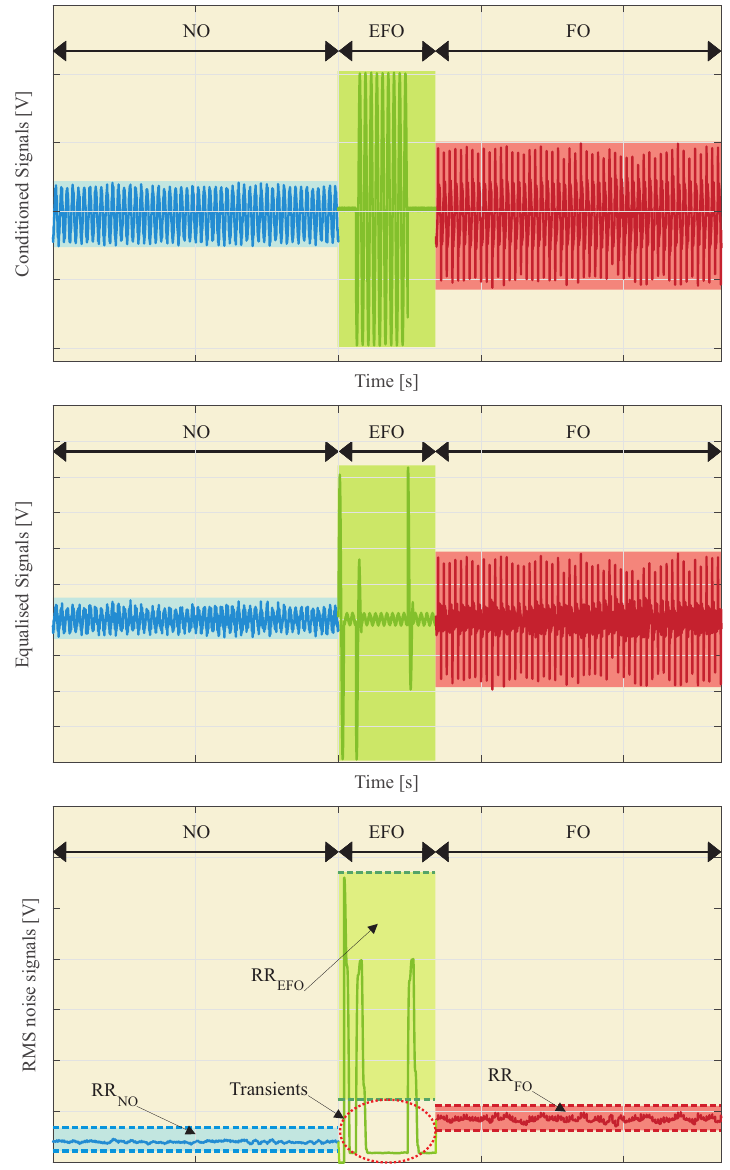
Figure 10. Example of results for conditioned, equalized, and RMS noise signals during NO, EFO, and FO of the